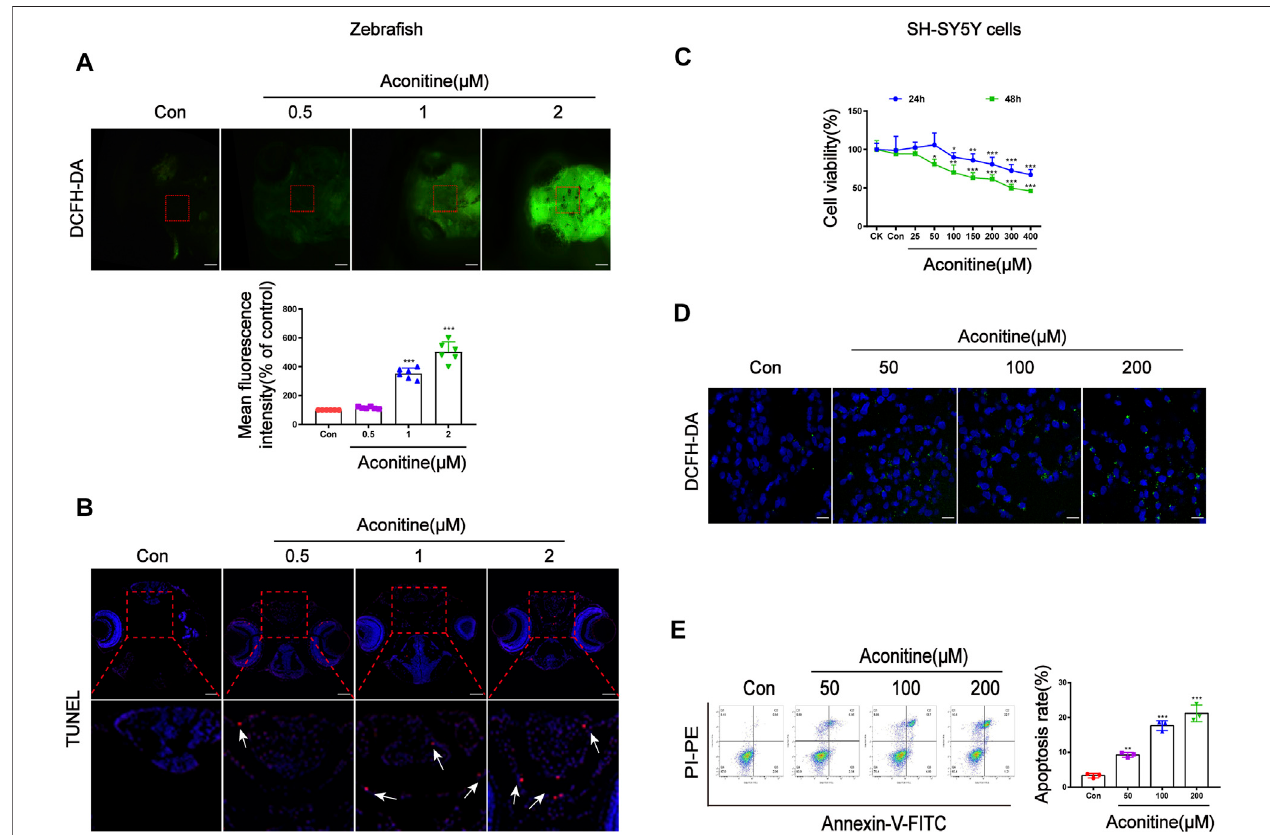
FIGURE 2 | Cell damage of zebra fi sh larvaes and SH-SY5Y cells caused by aconitine. (A) The images of aconitine-treated larvaes by DCFH-DA (100×), n = 6. (B) Theimagesofaconitine-exposedlarvaesbyTUNELassay(100×), n =3. (C) CellviabilityofSH-SY5Ycellsafter24 hor48 haconitineexposure, n =8. (D) Theimagesof aconitine-treatedSH-SY5YcellsbyDCFH-DA(200×), n =3. (E) SH-SY5Ycellapoptosisaconitine-inducedbasedonAnnexinV/PIdoublestainingby fl owcytometry, n = 3. All photographs were taken under a stereoscopic fl uorescence microscope or confocal microscope. The values are expressed as mean ± SD. * p < 0.05, ** p < 0.01, *** p < 0.001 vs. control